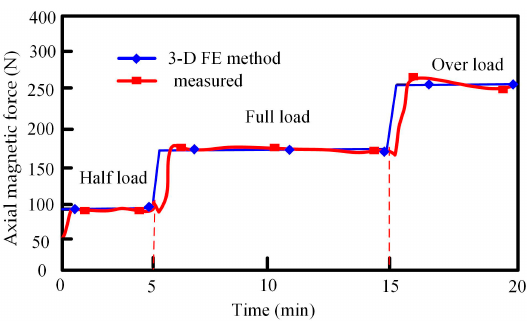
Figure 20. Comparison of the axial magnetic force curves between simulated and experimental results when keeping the rotor axial displacement unchanged ( Δ z = 0).